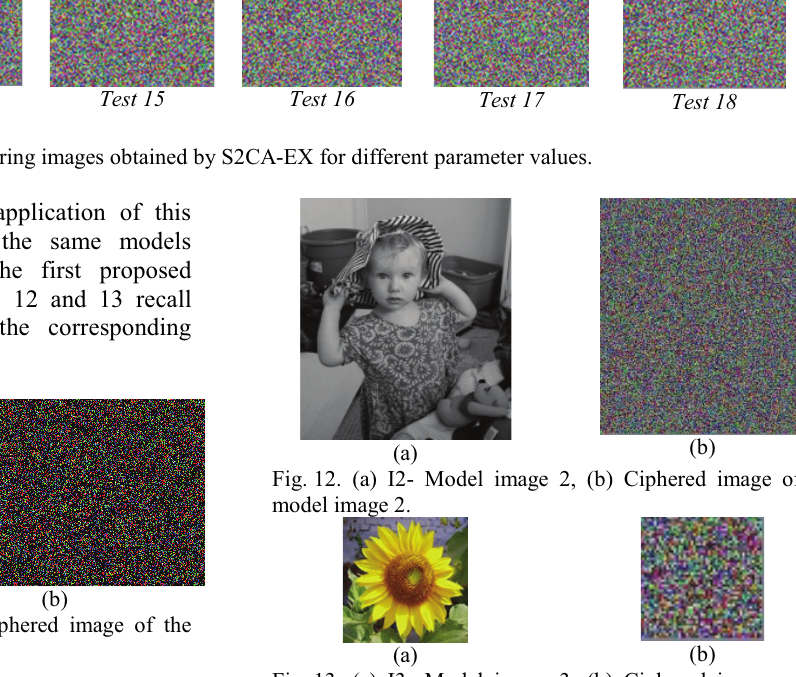
Fig. 13. (a) I3- Model image 3, (b) Ciphered image of the model image 3.